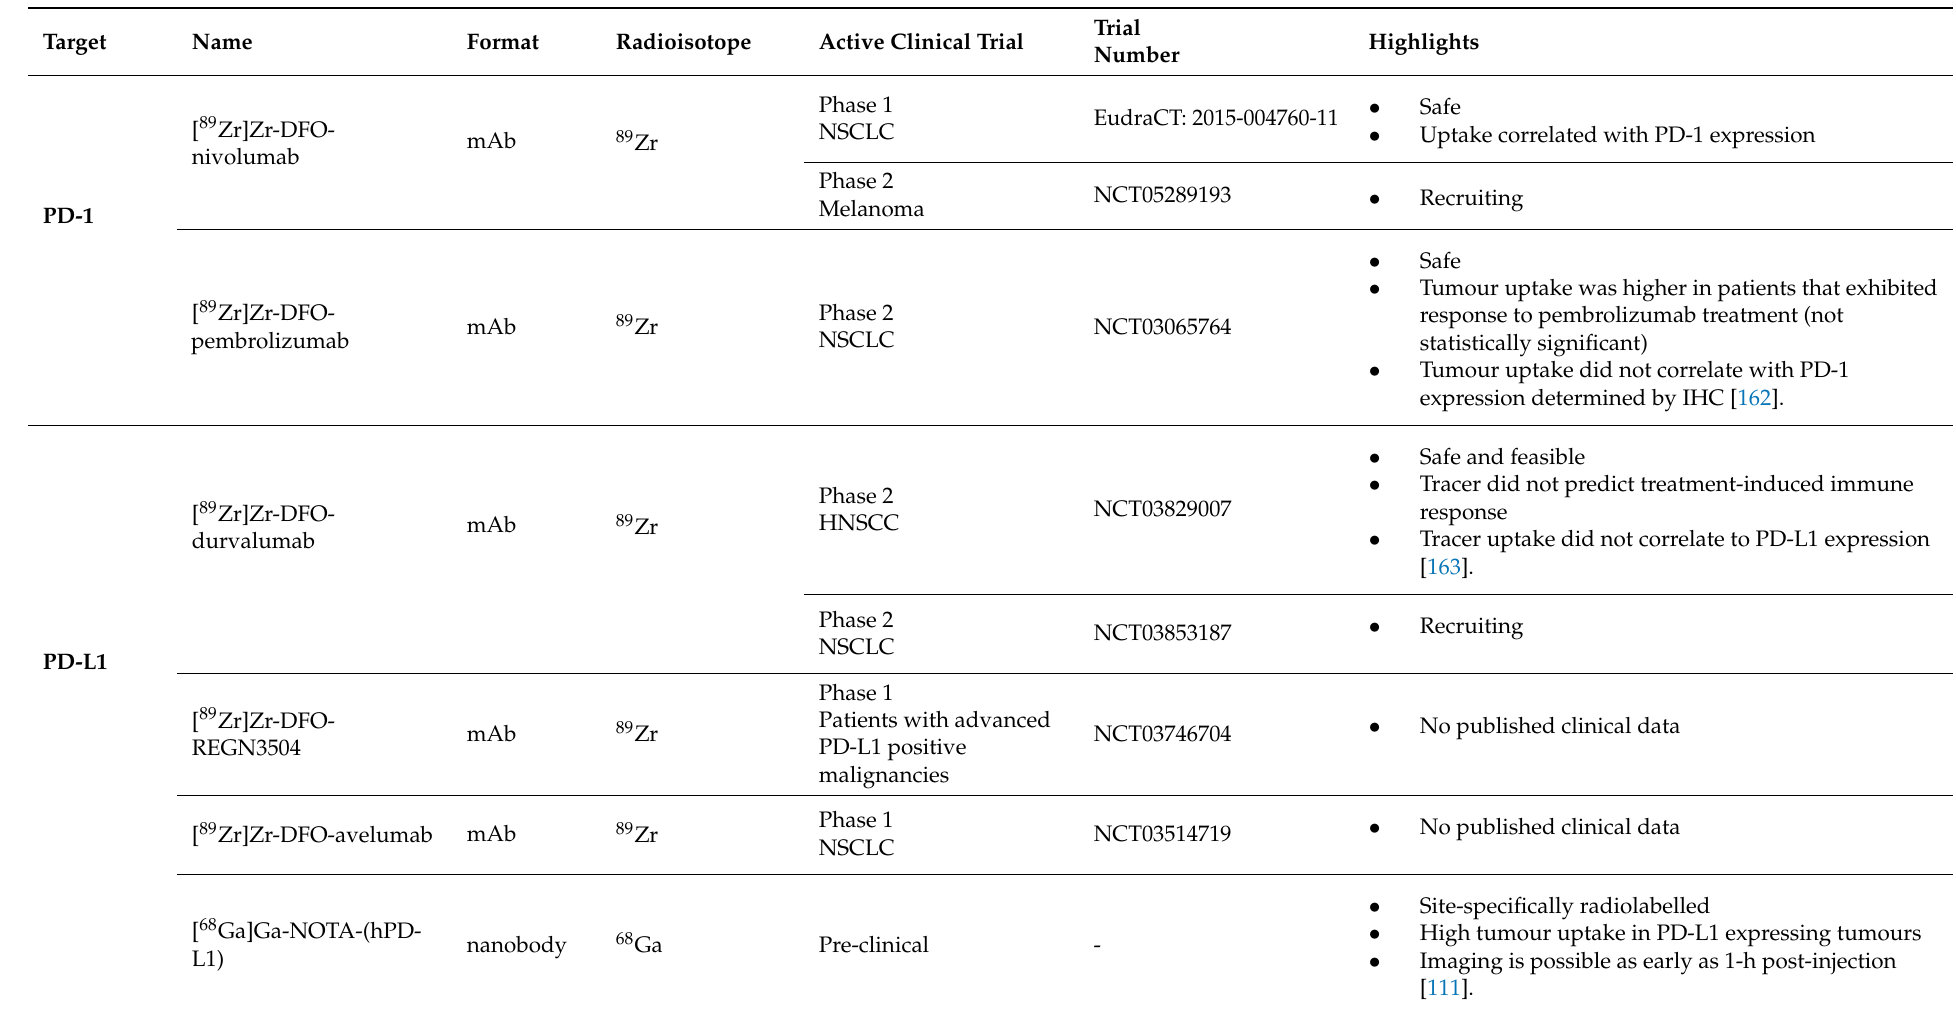
Table 4. Overview of PET probes under evaluation for imaging treatment-induced immune